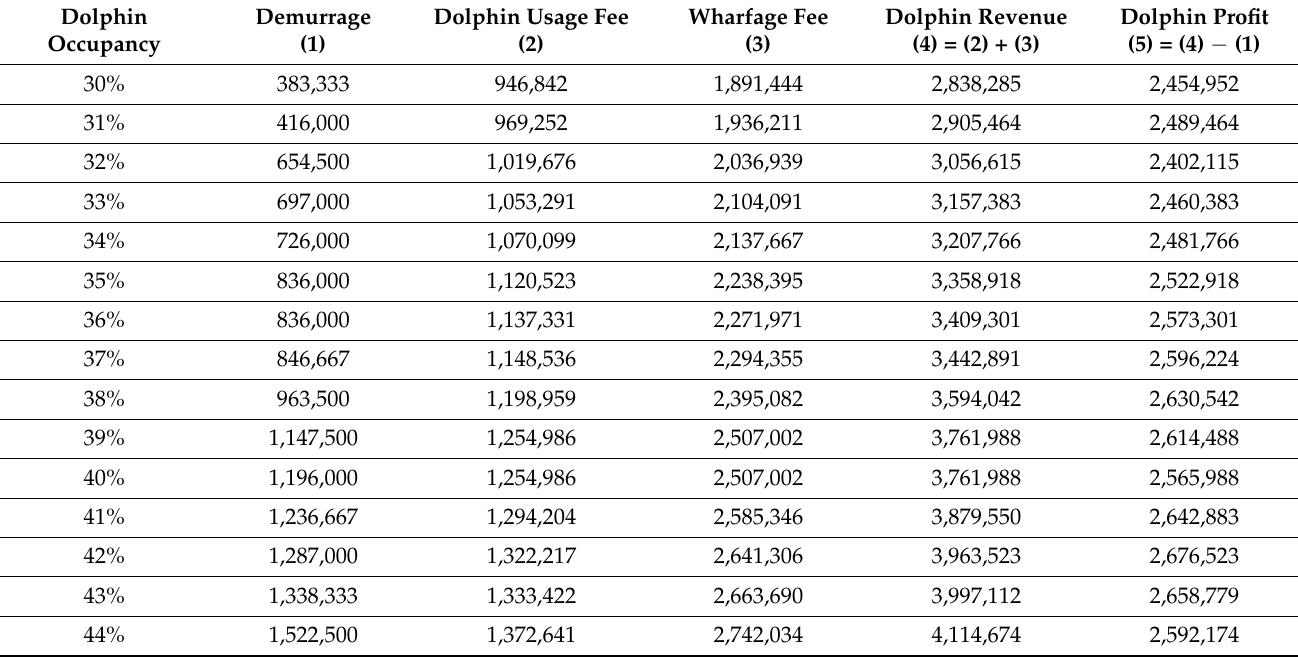
Table 6. Dolphin profit and occupancy with USD 40,000 demurrage per